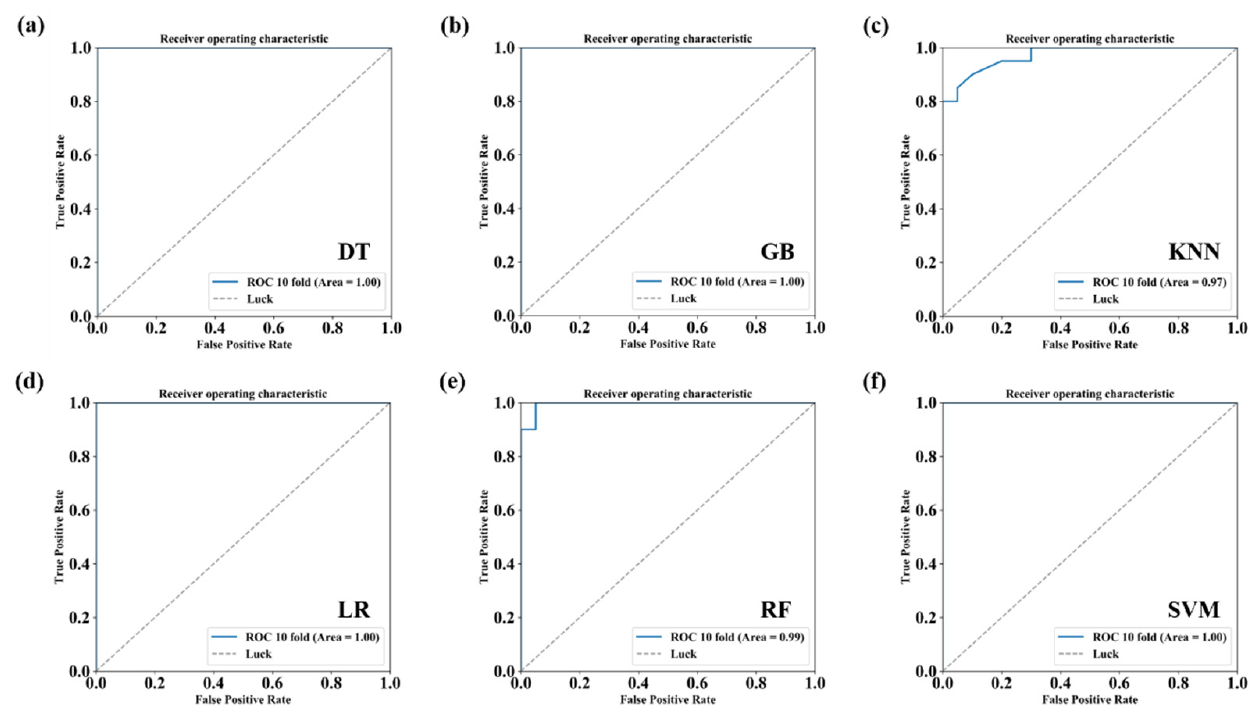
Figure 3. Performance of six machine learning methods (DT, GB, KNN, LR, RF, and SVM, as shown in Figure 3a–f) on differentially expressed circRNAs for predicting hepatocellular carcinoma. DT: Decision Tree. GB: Gradient Boosting. KNN: K-Nearest Neighbor. LR: Logistic Regression. RF: Random Forest. SVM: Support Vector